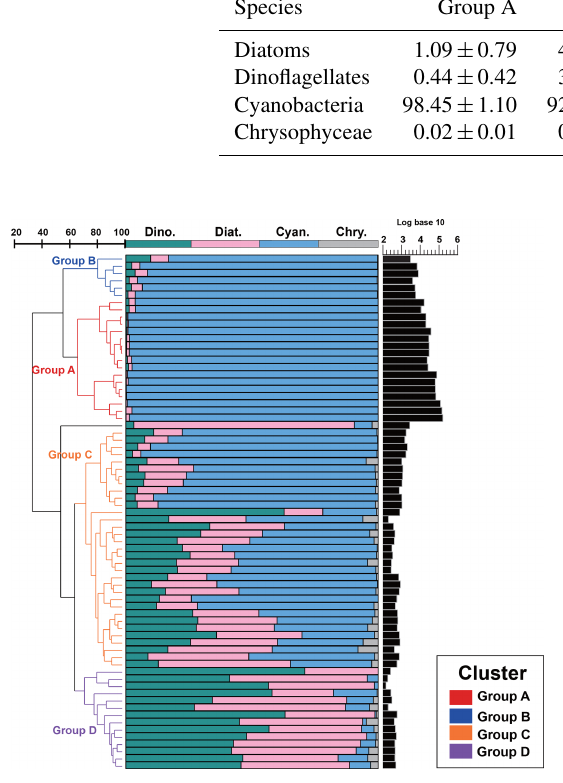
Figure 6. Bray–Curtis similarity-based dendrogram showing av- eraged phytoplankton community composition and abundance for each station across the three cruises. For each station, community composition is indicated with bar plots and phytoplankton abun- dance is represented with black bars.